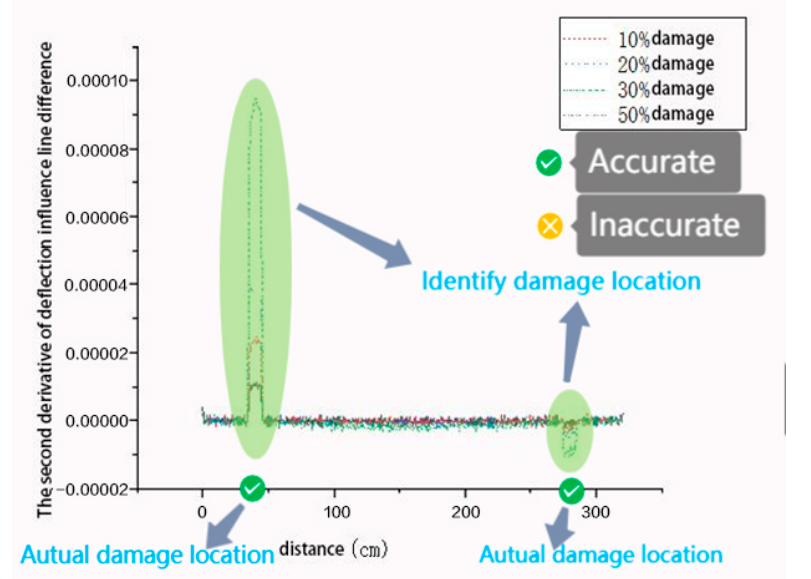
Figure 22. The 2nd derivative of deflection influences line difference at 1/4 determining point of the 1st span following work condition 1 (2-5).